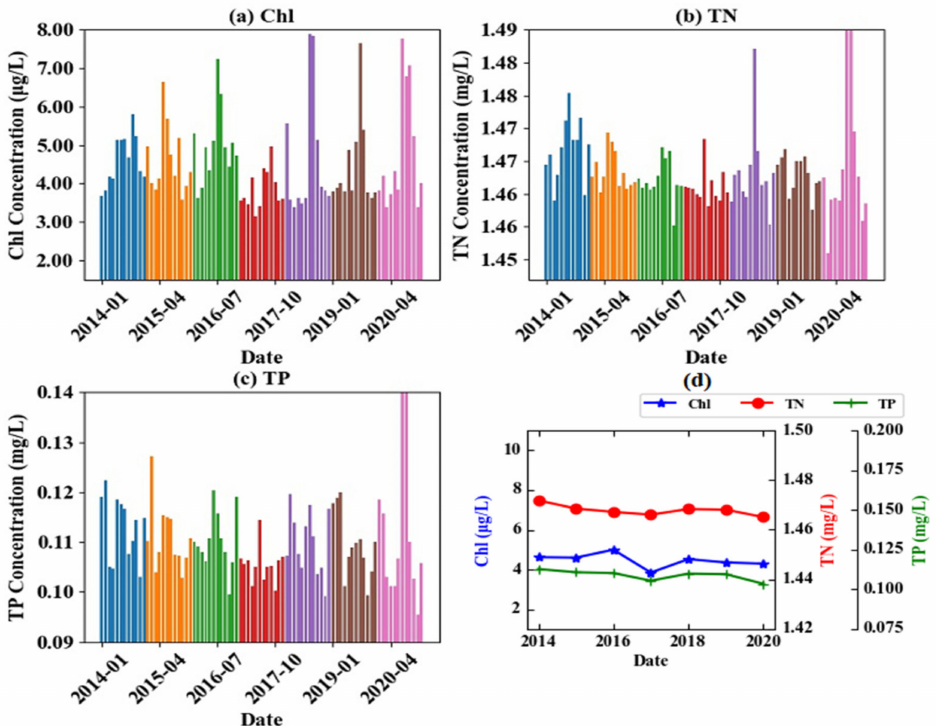
Figure 5. Water quality parameters variations of the Yangtze River from January 2014 to December 2020. ( a – c ) are the monthly variations of Chl-a, TN, and TP concentration, respectively, and ( d ) is the annual trend.